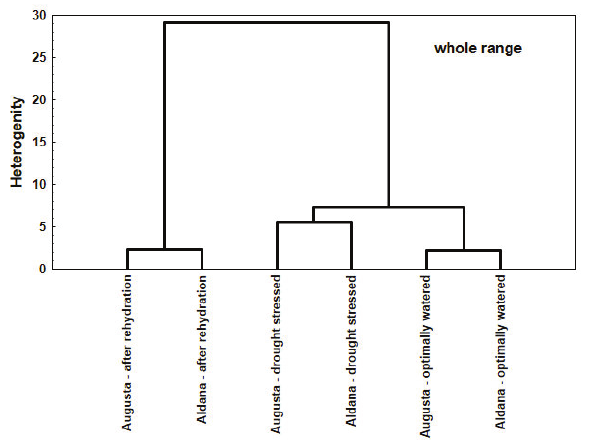
Figure 2: Cluster analysis of the FT-Raman spectra of soybean leaves (cv. Aldana and cv. Augusta) performed according to Ward’s algorithm in the whole wavenumber range with standard algorithm as data preprocessing.